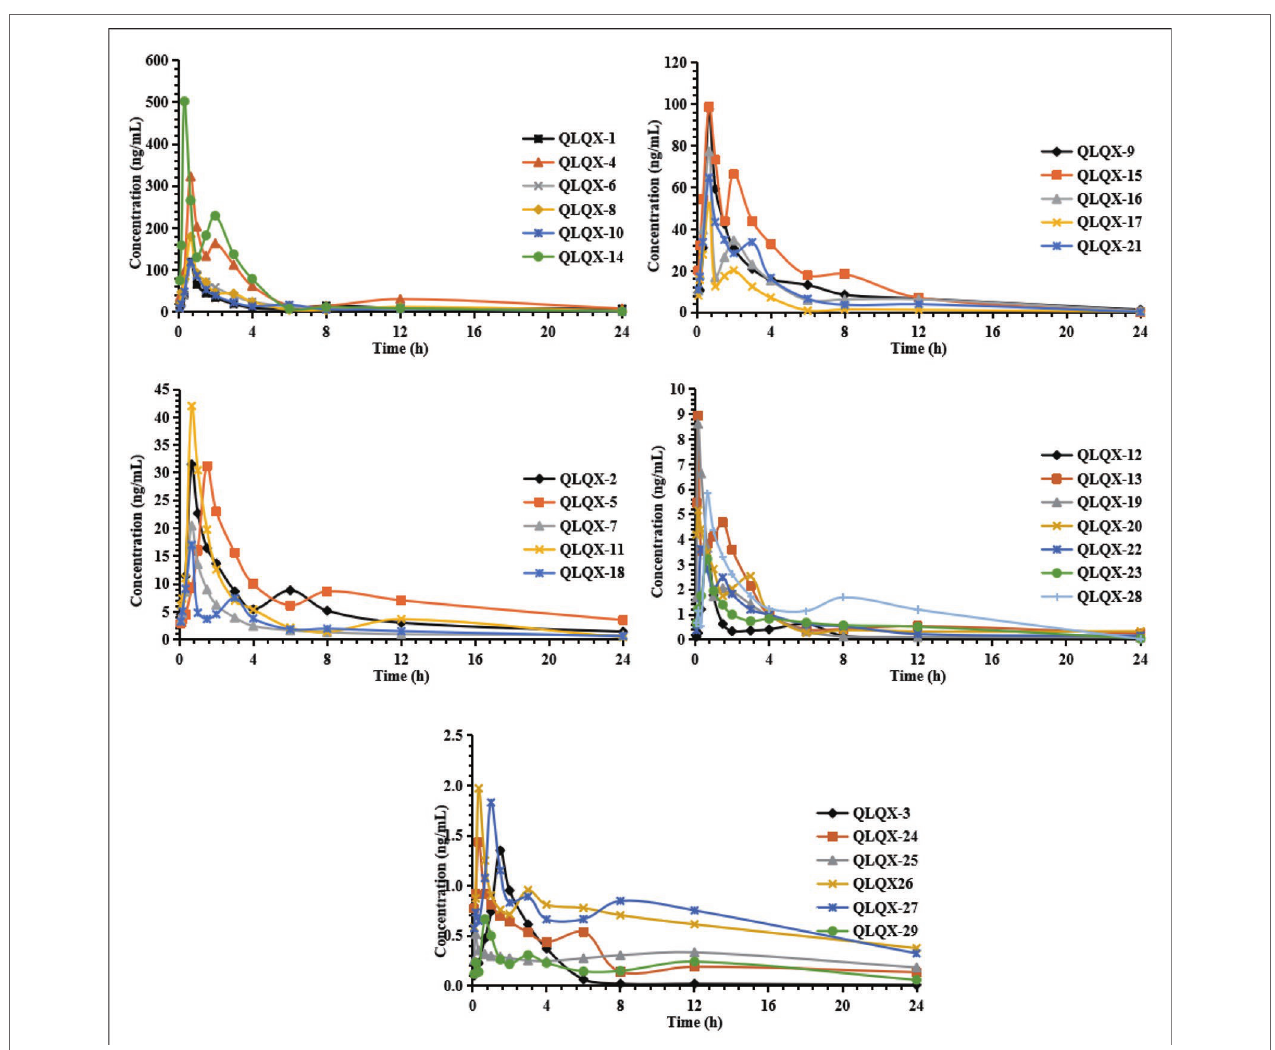
FIGURE 2 | Mean concentration-time profiles of astragaloside (QLQX-1), calycosin-7-glucoside (QLQX-2), sinapine bisulfate (QLQX-3), ginsenoside Rb 1 (QLQX-4), Rb 2 (QLQX-5), Rg 1 (QLQX-6), Rg 3 (QLQX-7), Rc (QLQX-8), Rd (QLQX-9), Re (QLQX-10), Rf (QLQX-11), F 2 (QLQX-12), salvianolic acid A (QLQX-13), salvianolic acid B (QLQX-14), danshensu (QLQX-15), lithospermic acid (QLQX-16), rosmarinic acid (QLQX-17), protocatechuic acid (QLQX-18), hydroxysafflor yellow A (QLQX-19), formononetin (QLQX-20), hesperidin (QLQX-21), rutin (QLQX-22), quercetin (QLQX-23), aconitine (QLQX-24), mesaconitine (QLQX-25), hypaconitine (QLQX-26), benzoylaconine (QLQX-27), benzoylmesaconine (QLQX-28), benzoylhypaconine